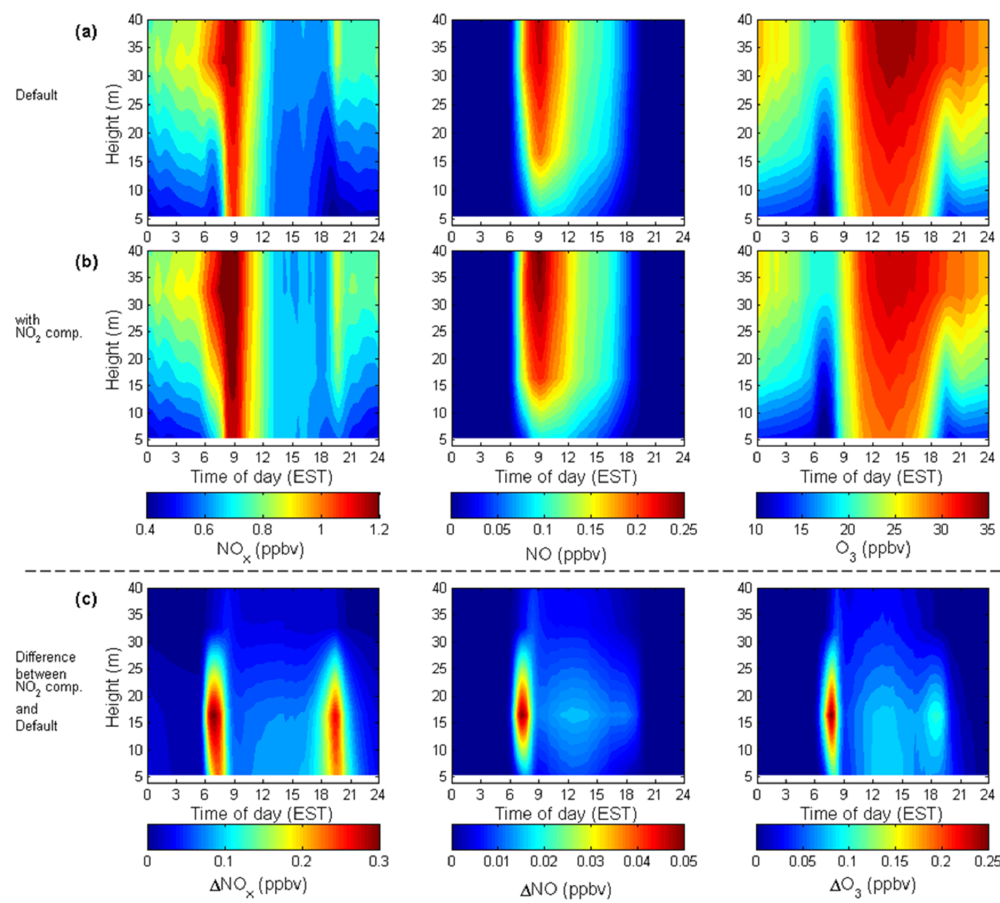
Fig. 13. Simulated August diurnal vertical profiles of NO x , NO , and O 3 mixing ratios using (a) default parameters and (b) parameters with 1 ppbv NO 2 compensation point. (c) The difference between simulation considering NO 2 compensation point and the default ( ∆ = NO 2 compensation point simulation − default simulation).